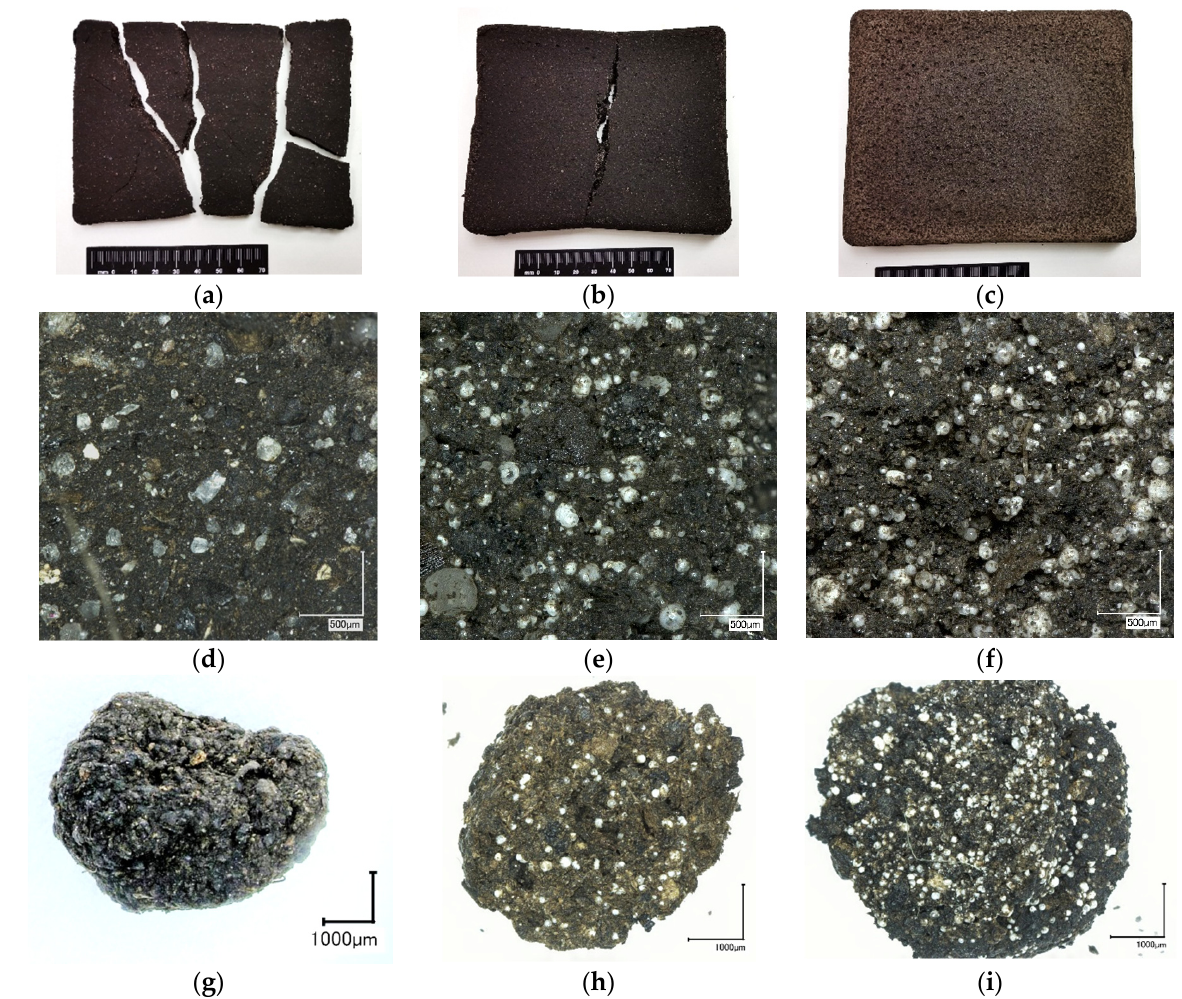
Figure 7. Images of CS–DCR–homogenised peat (HP) composite material: common appearance of dried block 0-100-0 ( a ), 5-90-5 ( b ), and 20-70-10 ( c ); micro-images of blocks 0-100-0 ( d ), 5-90-5 ( e ), 20-70-10 ( f ) fractures: and granules: 0-100-0 ( g ), 5-90-5 ( h ), and 20-70-10 ( i ) common appearances.